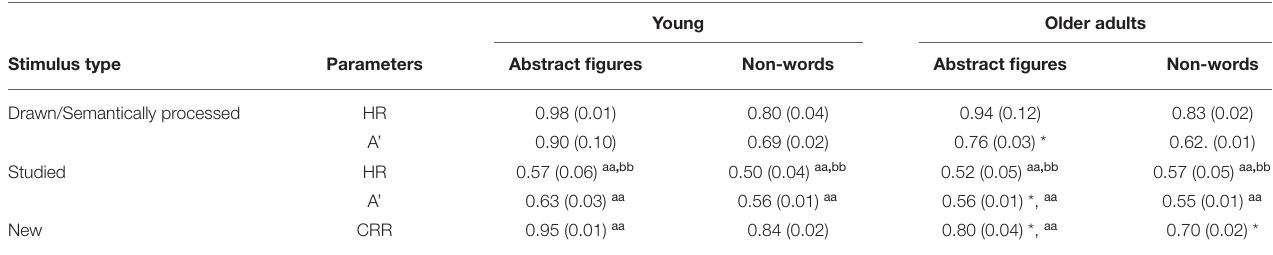
TABLE 3 | Means (SEMs) of the signal-detection measures concerning the recognition performance with the abstract figures and non-words for the drawn/semantically processed, studied, and new stimuli according to age (young and older